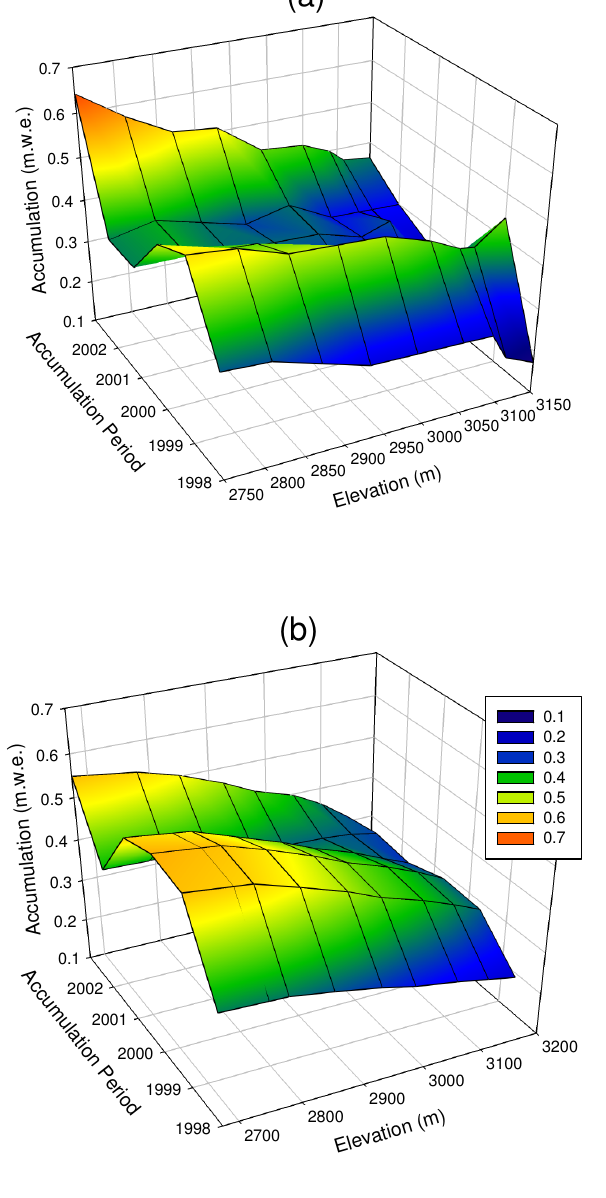
Fig. 4. Observed (a) and modelled (b) mean annual accumulation rates for